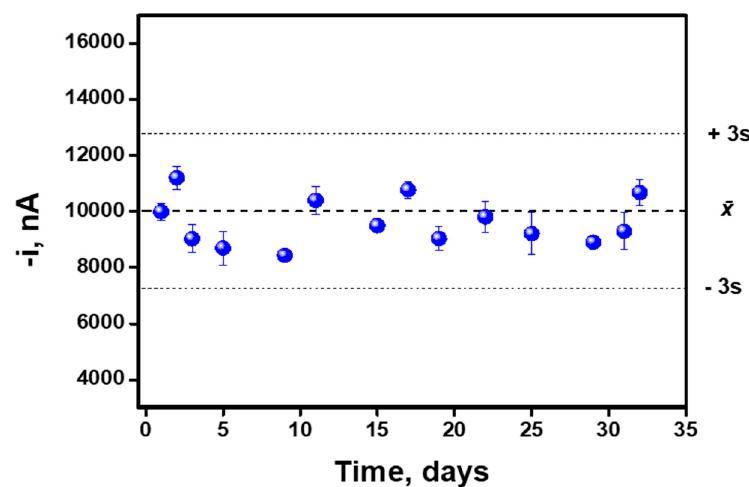
Figure 4. Stability of the MB–cAb complexes. Central and limit lines correspond to average ± three times the standard deviation (n = 14) obtained for inter-day immunoassays. Each individual point corresponds to the average ± standard deviation (n = 3) obtained for the intra-day immunoassays.